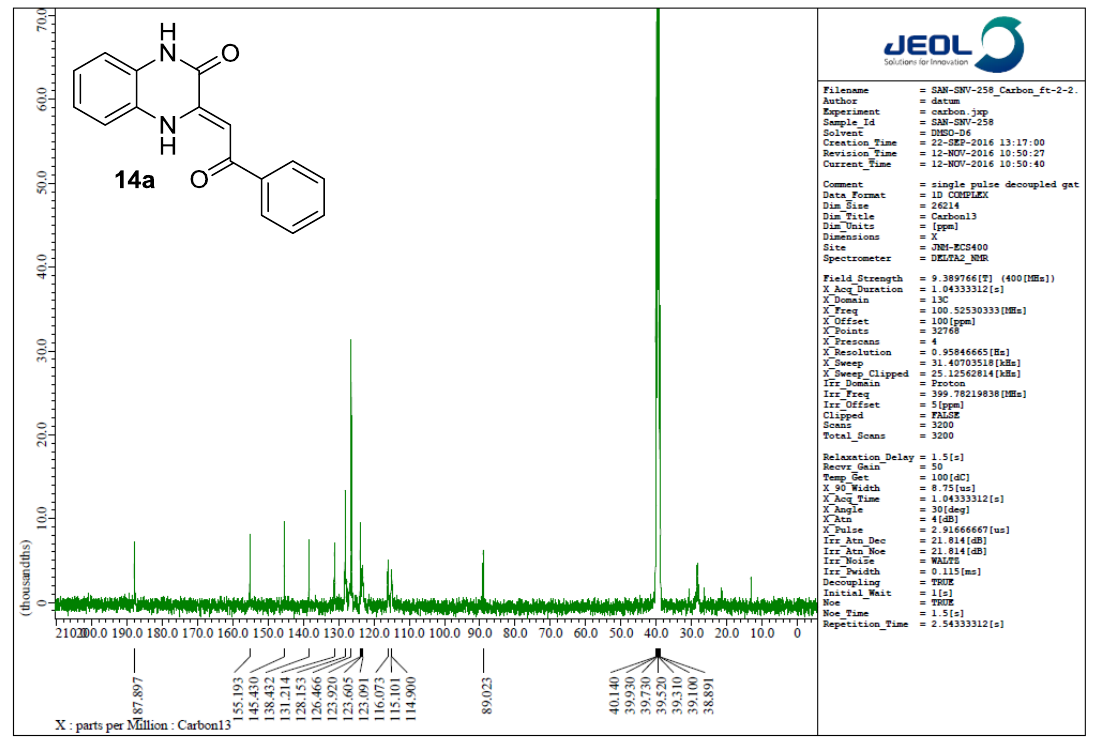
Figure 30 . 13 C NMR Spectra of Compound 14a